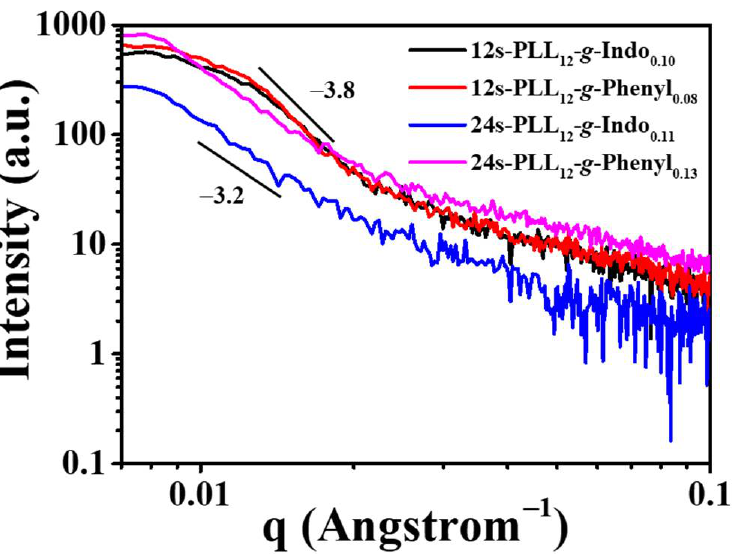
Figure 4. SAXS spectra of 12-armed and 24-armed polypeptide hydrogel samples with the polypep- tide concentration of 8.0 wt%.